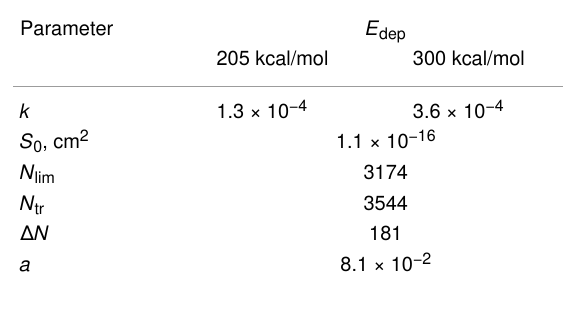
Table 3: Parameters from Equation 10 providing the best fit of the ana- lytical dependence with the one obtained from simulations. k is a scaling coefficient of the number of adsorbed precursors, S 0 is the effective beam spot area, N lim is the estimated limiting number of Pt atoms in the nanostructure, N tr is the number of adsorbed precursors in the transition point, Δ N is an interval of N p values within which the morphological transition takes place, and a is the coefficient of the linear cluster